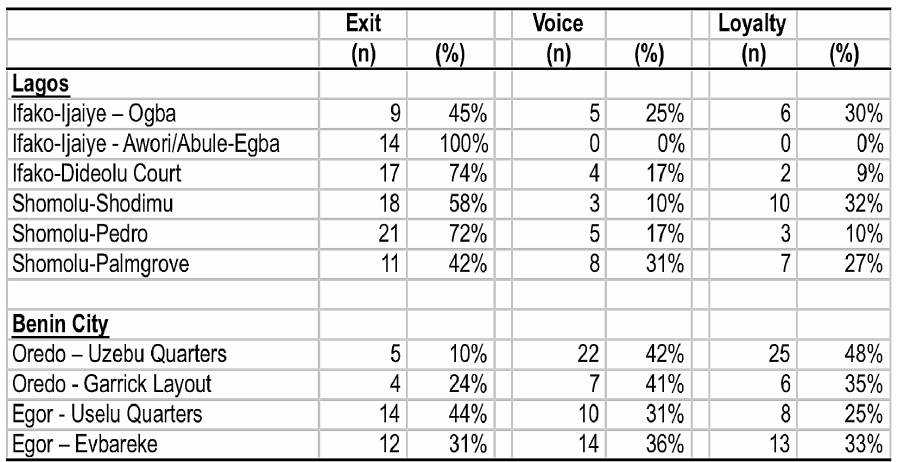
Table 6. Responses to water problems by neighborhood